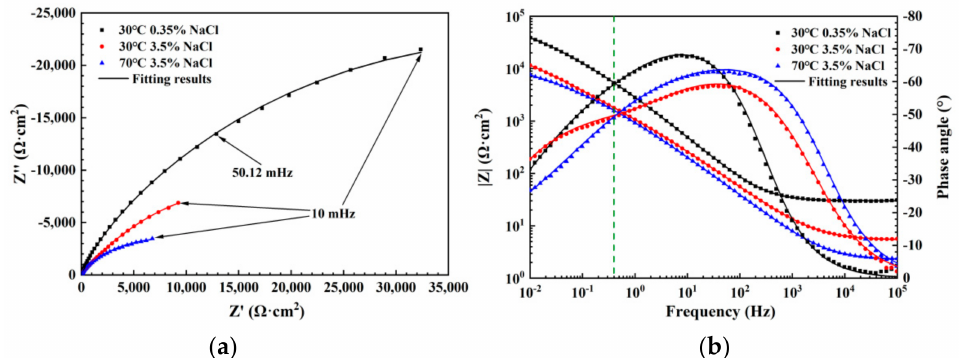
Figure 4. Electrochemical impedance spectroscopy (EIS) behavior and fitting results of the Fe-based AMCs coating samples. ( a ) Nyquist plots; ( b ) Bode/Bode-phase